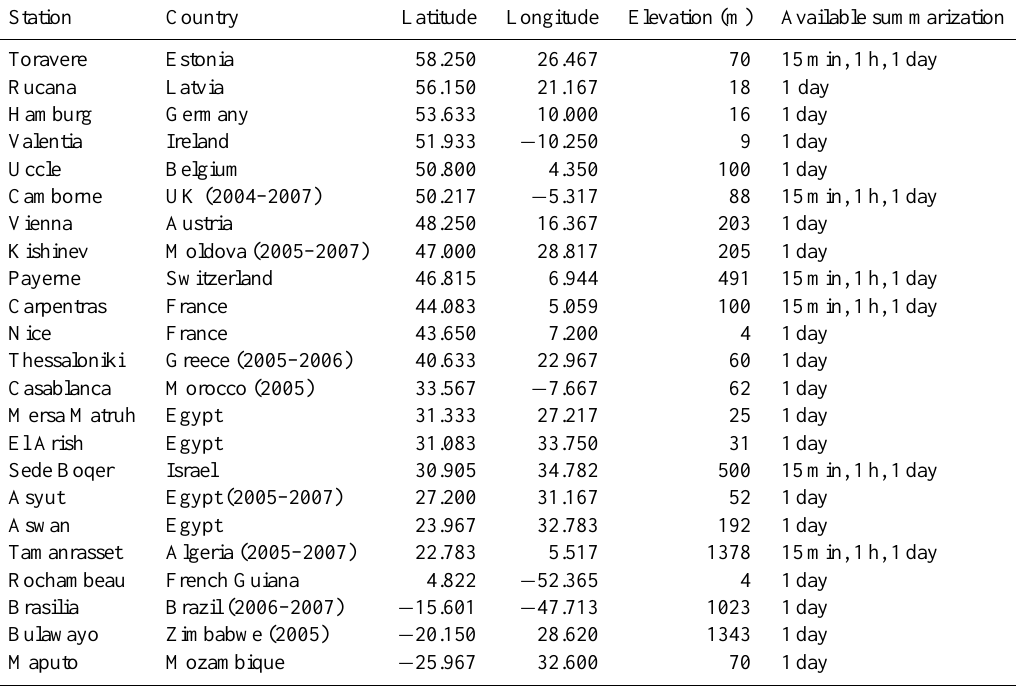
Table 1. List of stations, ordered from north to south. Data from 2005 to 2009, except if stated otherwise. Station